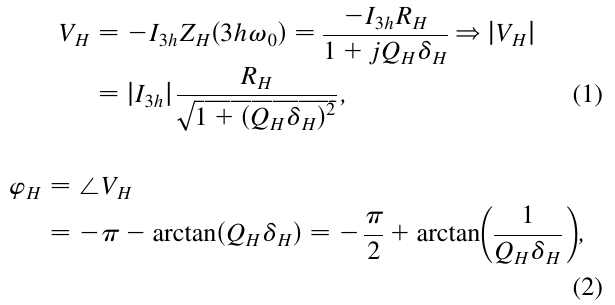
Proposed DA(cid:3)NE rf parameter set.